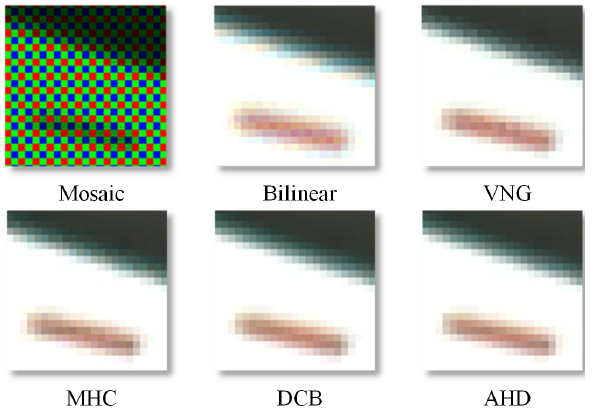
Figure 2. Example of different debayering algorithms.